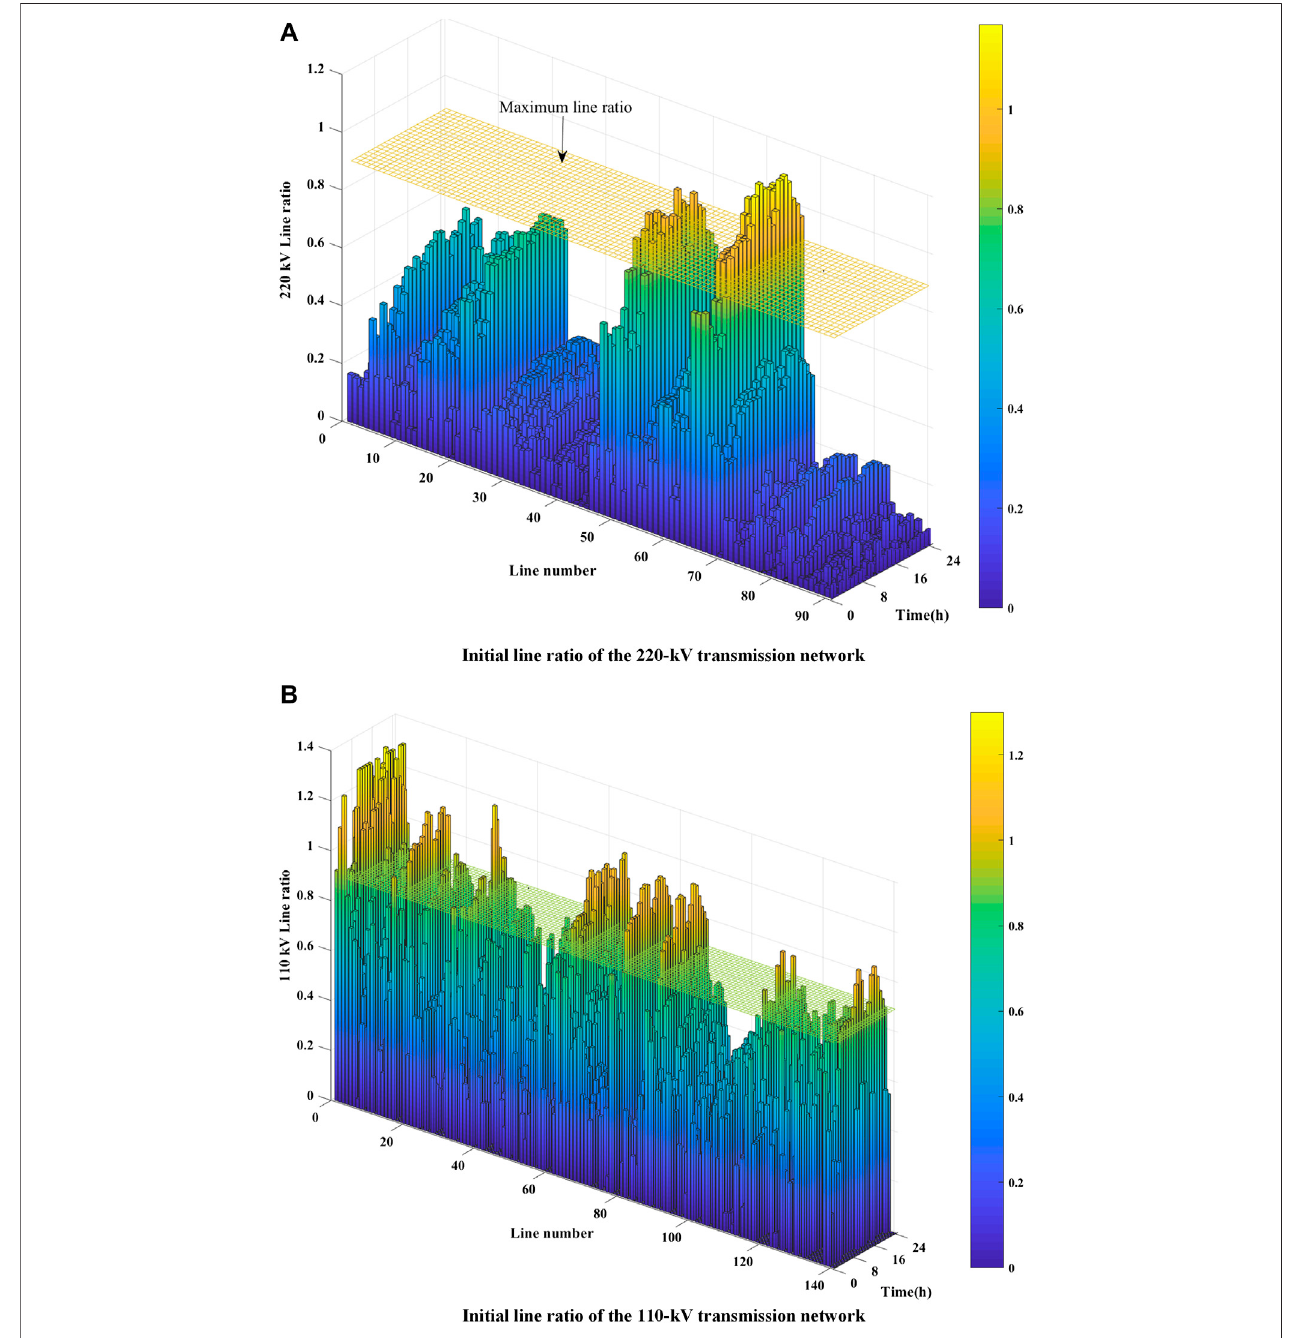
FIGURE 9 | System initial operation condition. (A) initial line ratio of the 220-kV transmission network. (B) initial line ratio of the 110-kV transmission network.